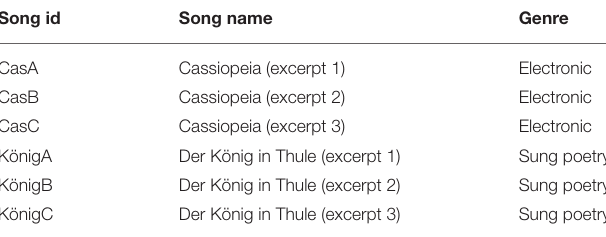
TABLE 4 | Music tracks used in experiment